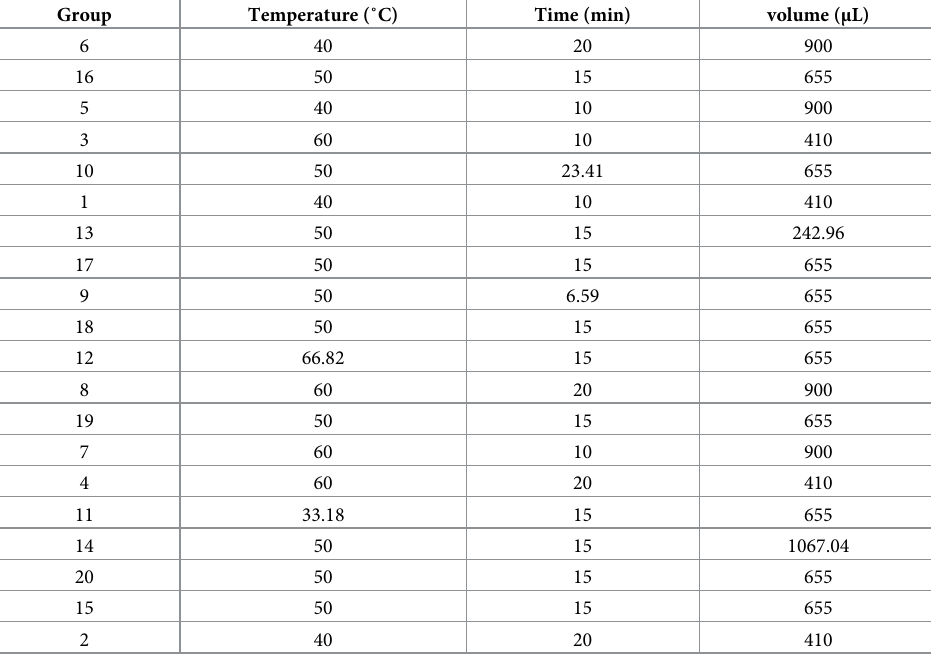
Table 2. The design of 20 random